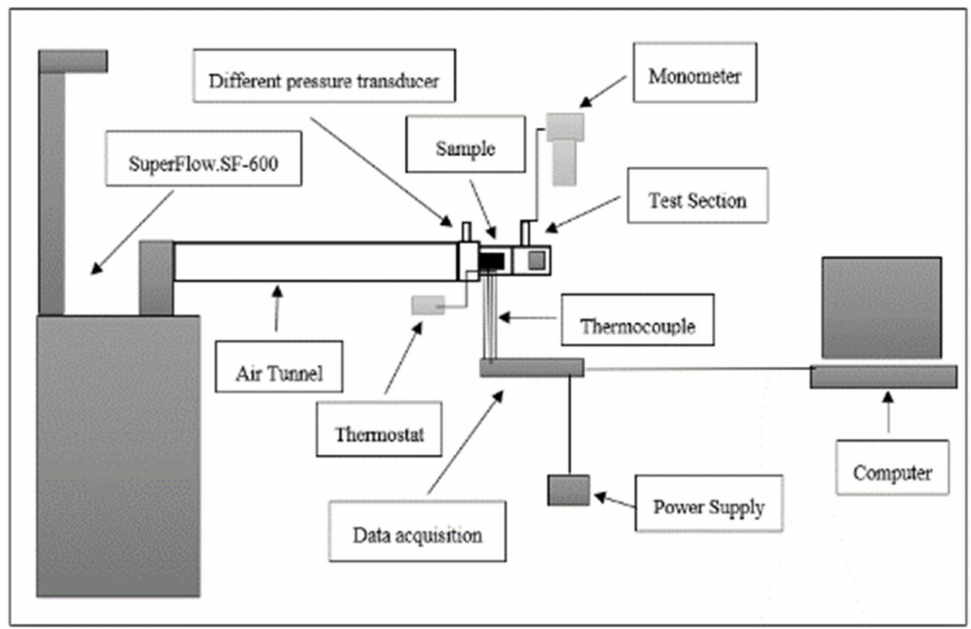
Figure 10. Schematic of the complete experimental